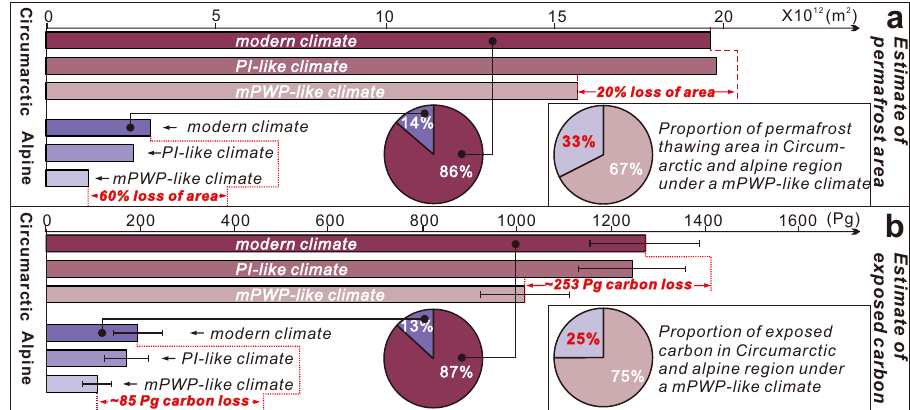
Fig. 5 Estimated permafrost thawing and carbon affected under warmer climatic conditions. a Estimates of permafrost destabilisation and associated organic carbon from circumarctic and alpine permafrost regions in mPWP-like and pre-industrial(PI)-like climatic conditions. In a mPWP-like climate, around ~20% of circumarctic permafrost (containing ~253 Pg of carbon) would cross the 0 °C isotherm compared with ~60% of alpine permafrost (containing ~85 Pg of carbon). b Proportion of carbon in the circumarctic and alpine permafrost regions in modern climate and the proportion of carbon in the circumarctic and alpine permafrost regions in a mPWP-like climate (assuming total mineralisation of thawed carbon). Note that although the total amount of carbon in the alpine permafrost region is ~13% of total carbon trapped in modern permafrost, the ~85 Pg of carbon exposed to thaw from alpine permafrost represents ~25% of the total exposed carbon from permafrost in a mPWP-like climate. The error bars shown in b represent the 1 σ error of amount of permafrost carbon with the calculation details shown in Supplementary Data 3. Region marked with 1 – 6 refers to the Tibetan